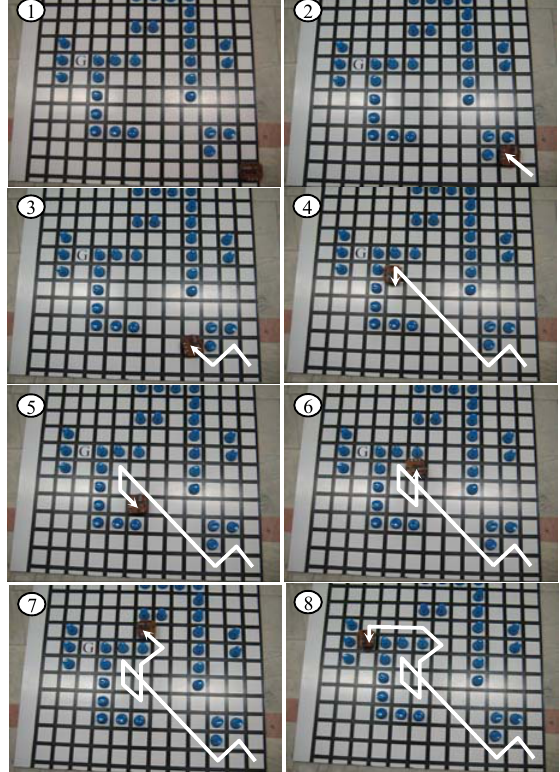
Fig.18. Eight snapshots of a single robot test in an environment with concave obstacles. The robot has escaped from concave region. The generated path by the proposed algorithm is shown by white